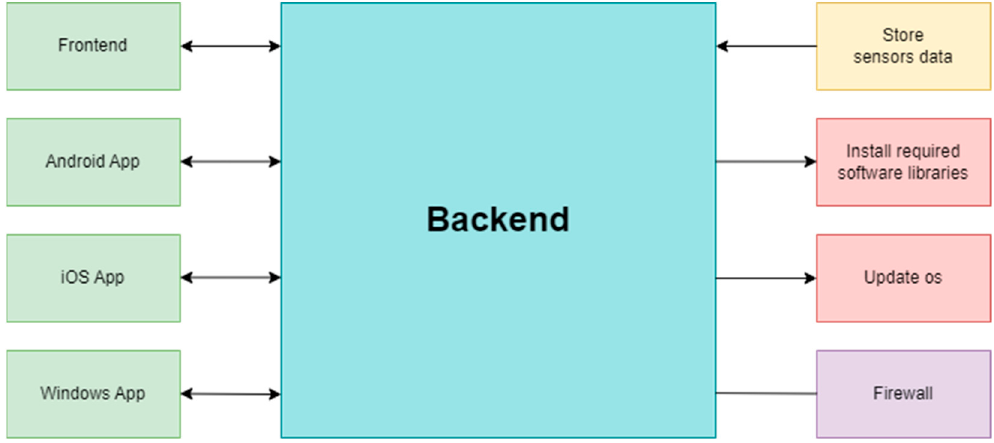
Figure 6. Main backend responsibilities.